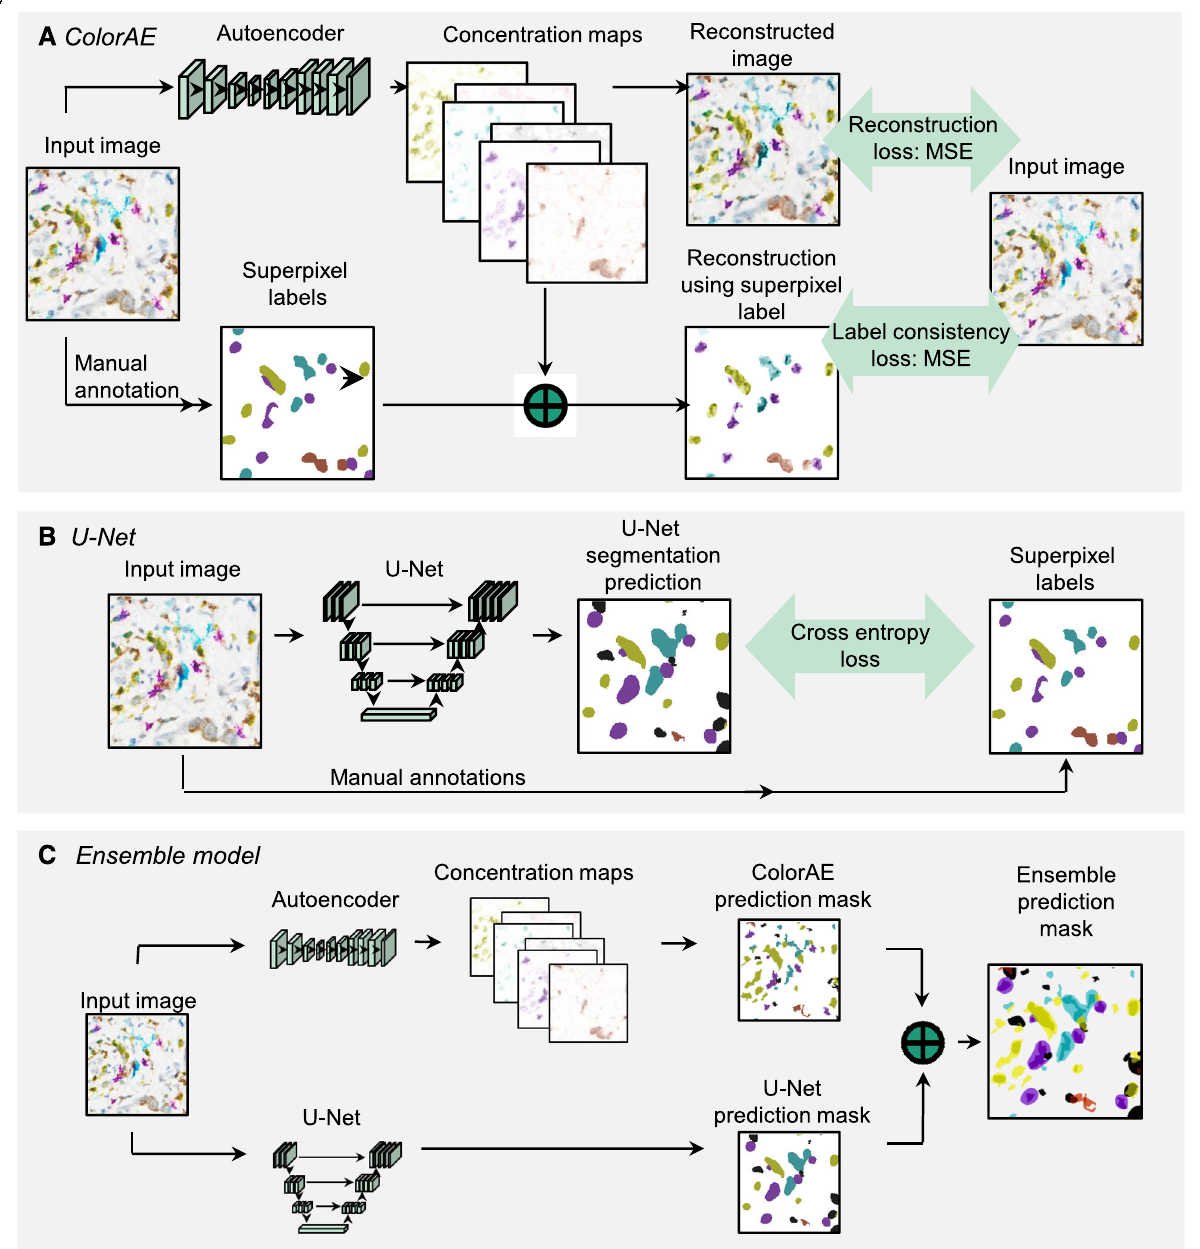
Fig. 3 Algorithm training. A . ColorAE training . Input image is run through an autoencoder to yield concentration maps of each color (6 distinct mIHC stain colors: yellow, teal, purple, red, black, brown; blue hematoxylin nuclear counterstain; and background.) Two loss functions are applied to ensure that the reconstructed image has the highest fidelity to the original image and expert weak annotations. B . U-Net training . Input image was run through a U-Net. Cross entropy loss function was applied to maximize fidelity to superpixel labels derived from manual annotation of the input image. C . Ensemble method workflow. Input image is run through the autoencoder and U-Net to generate predictions as shown